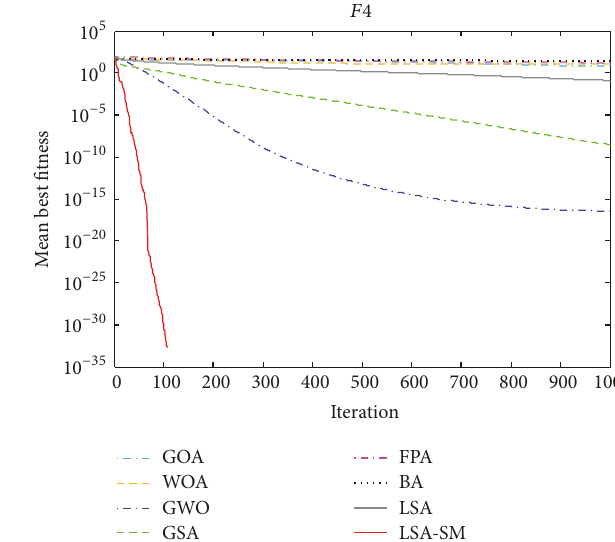
Figure 8: 𝐷 = 30 , convergence curves for 𝑓 04 .